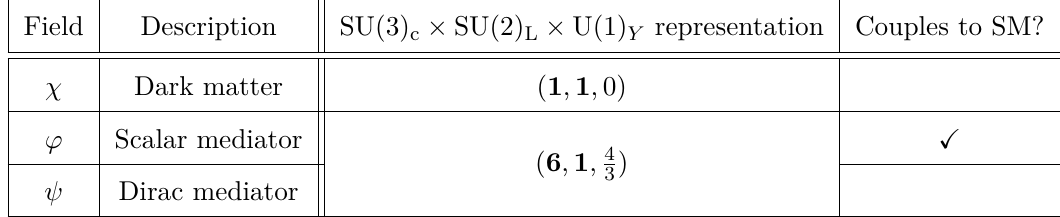
Table 1 . Novel field content in renormalizable model of Dirac dark matter investigated in this work. In this specific scheme, only ϕ couples directly to SM fields at tree